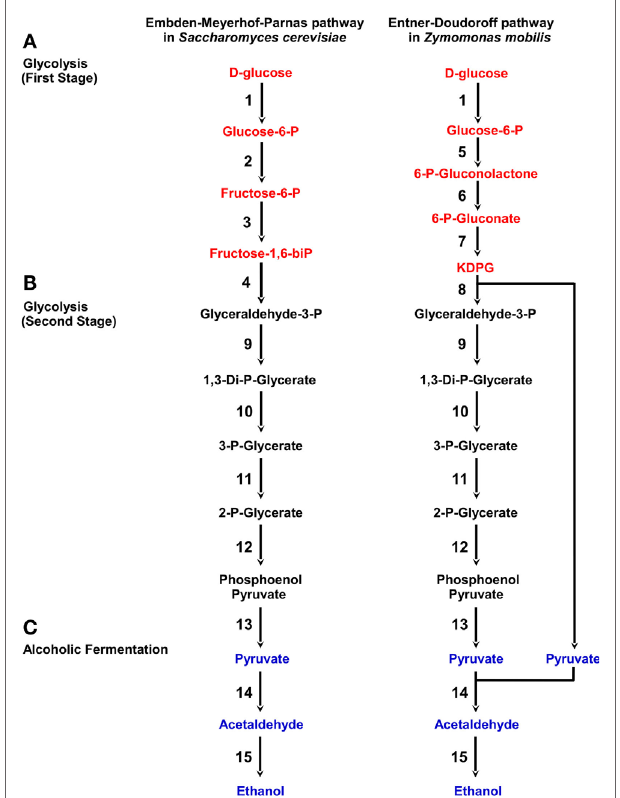
FiGURe 3 | The production of ethanol from glucose by embden– Meyerhof–Parnas pathway in Saccharomyces cerevisiae and entner–Doudoroff pathway in Zymomonas mobilis . The catalytic enzymes are denoted with numbers. The catalytic enzymes are